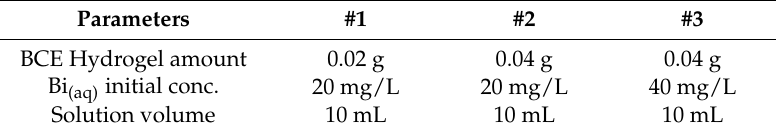
Table 1. Adsorption parameters for non-competitive adsorption of Bi 3+ .